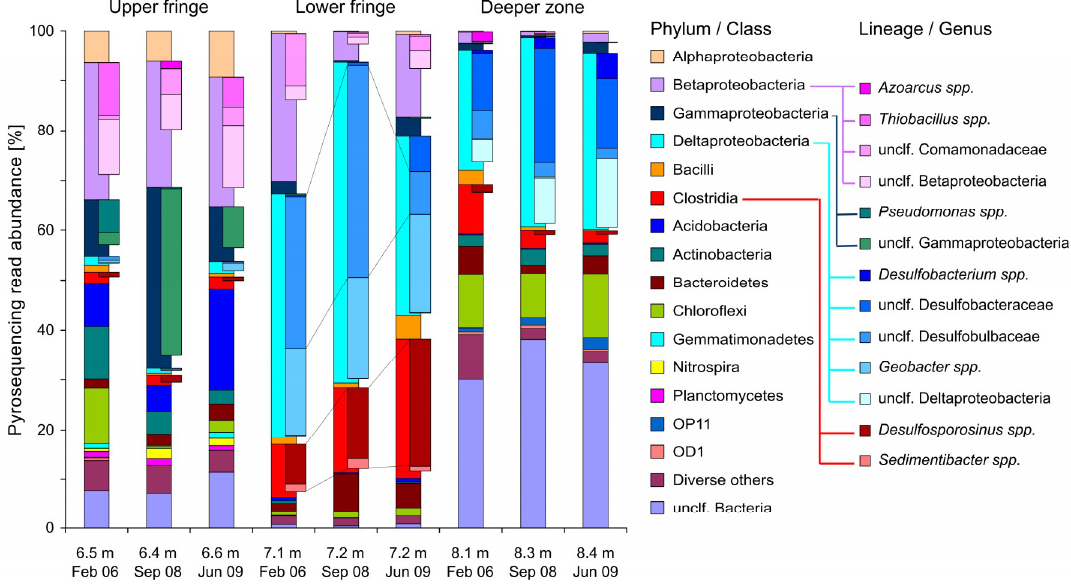
Figure 4. Temporal bacterial community dynamics in compartments of the Flingern hydrocarbon plume as revealed by amplicon pyrosequencing of 16S rRNA gene fragments. Total communities are resolved to phylum/class-level, while selected dominating and dynamic lineages are highlighted at the genus-level.